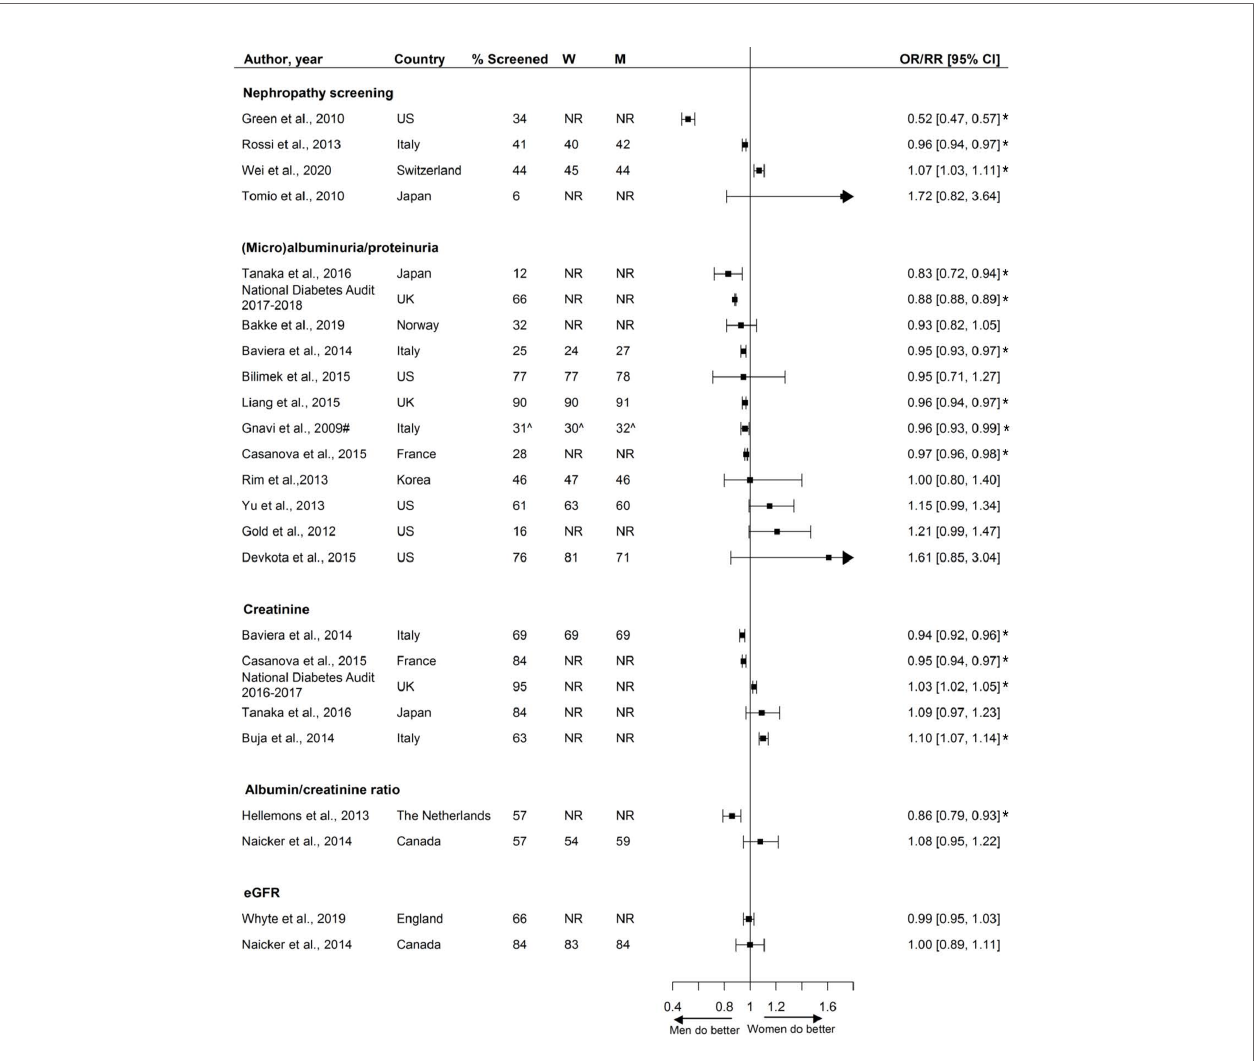
FIGURE 6 | Nephropathy screening, expressed as adjusted odds ratios (OR) or relative risks (RR) with corresponding 95% con fi dence intervals (CI). One study is not presented in this fi gure because of the measure of association: Swietek et al. (33): Average Marginal Effect, (SE; p-value): − 0.0073 ( − 0.0042; <0.05 (women less likely to receive screening). W = % of screened women; M = % of screened men; US, United States; UK, United Kingdom; # = Relative risk; ^ = Kaplan-Meyer estimate. Men = reference. * = statistically signi fi